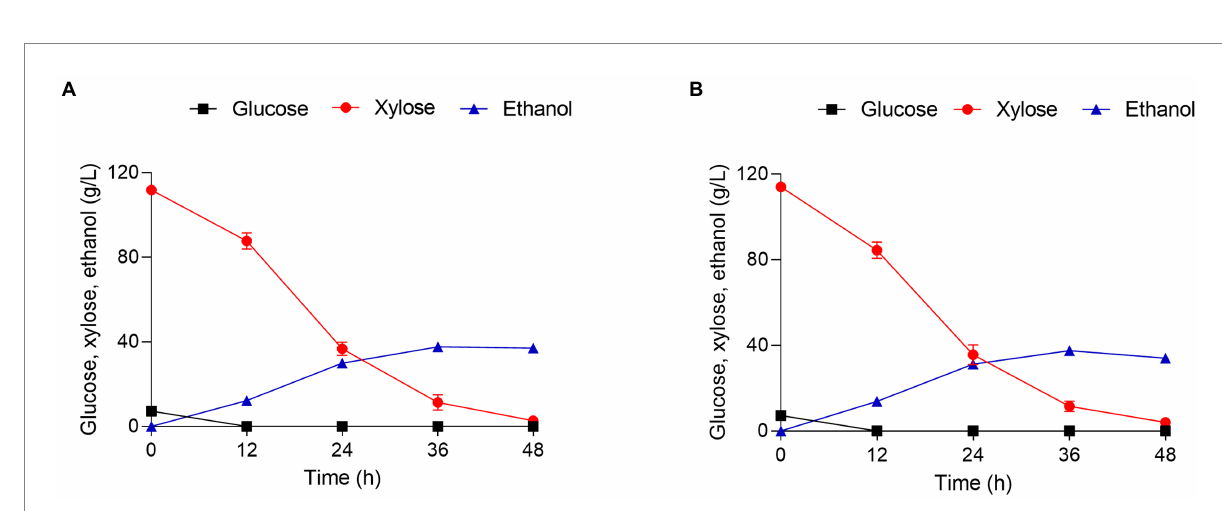
FIGURE 4 Xylose mother liquor hydrolysate fermentation and growth characteristics of strains WXY70 and GRE3 OE . Growth and fermentation characteristics of WXY70 (A) and GRE3 OE (B) within 48